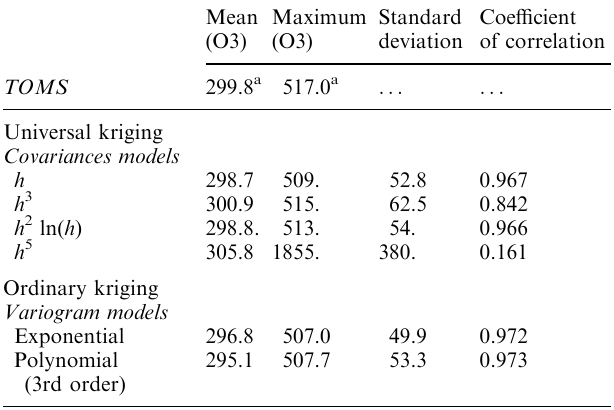
Table 3. Statistical results obtained by kriging of SBUV data using both ordinary (two di(cid:128)erent variogram models) and universal kriging (fixed drift: linear with di(cid:128)erent generalized covariances). Comparison is done with TOMS data (October 19, 1988)